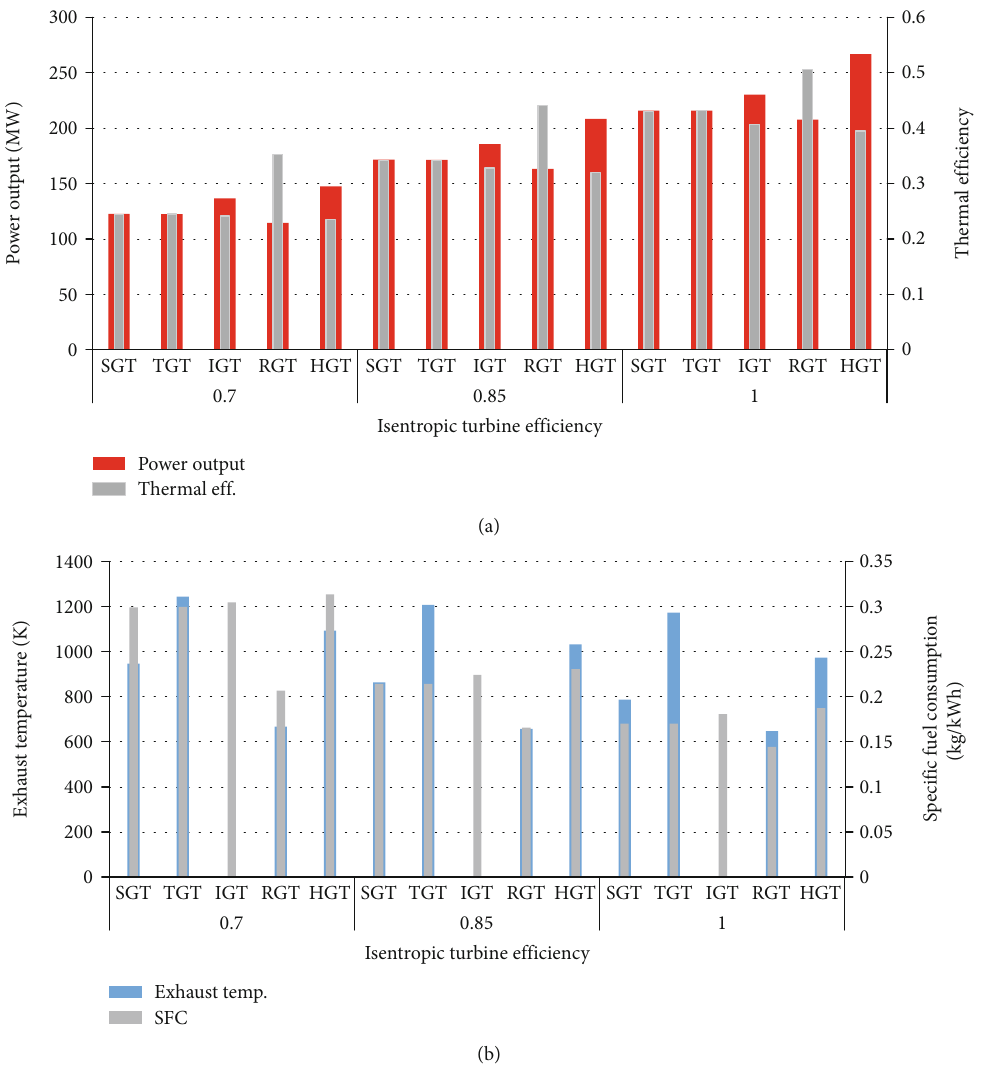
Figure 11: The impact of the isentropic turbine e ffi ciency ( T